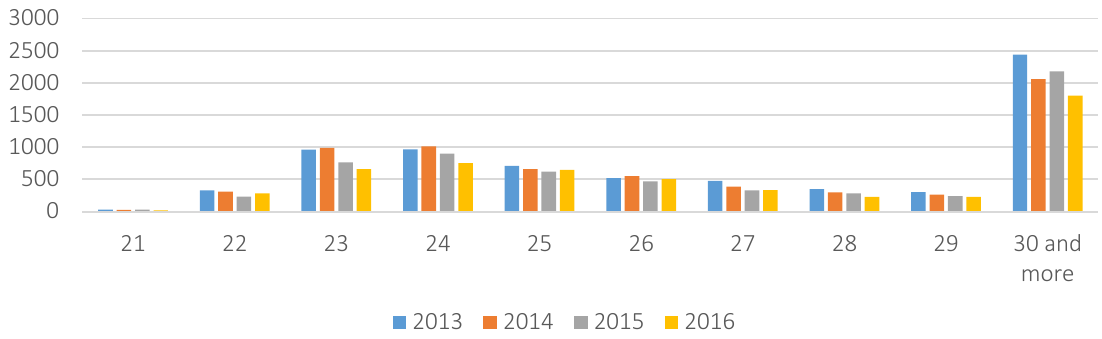
Figure 4. Graduated students per age